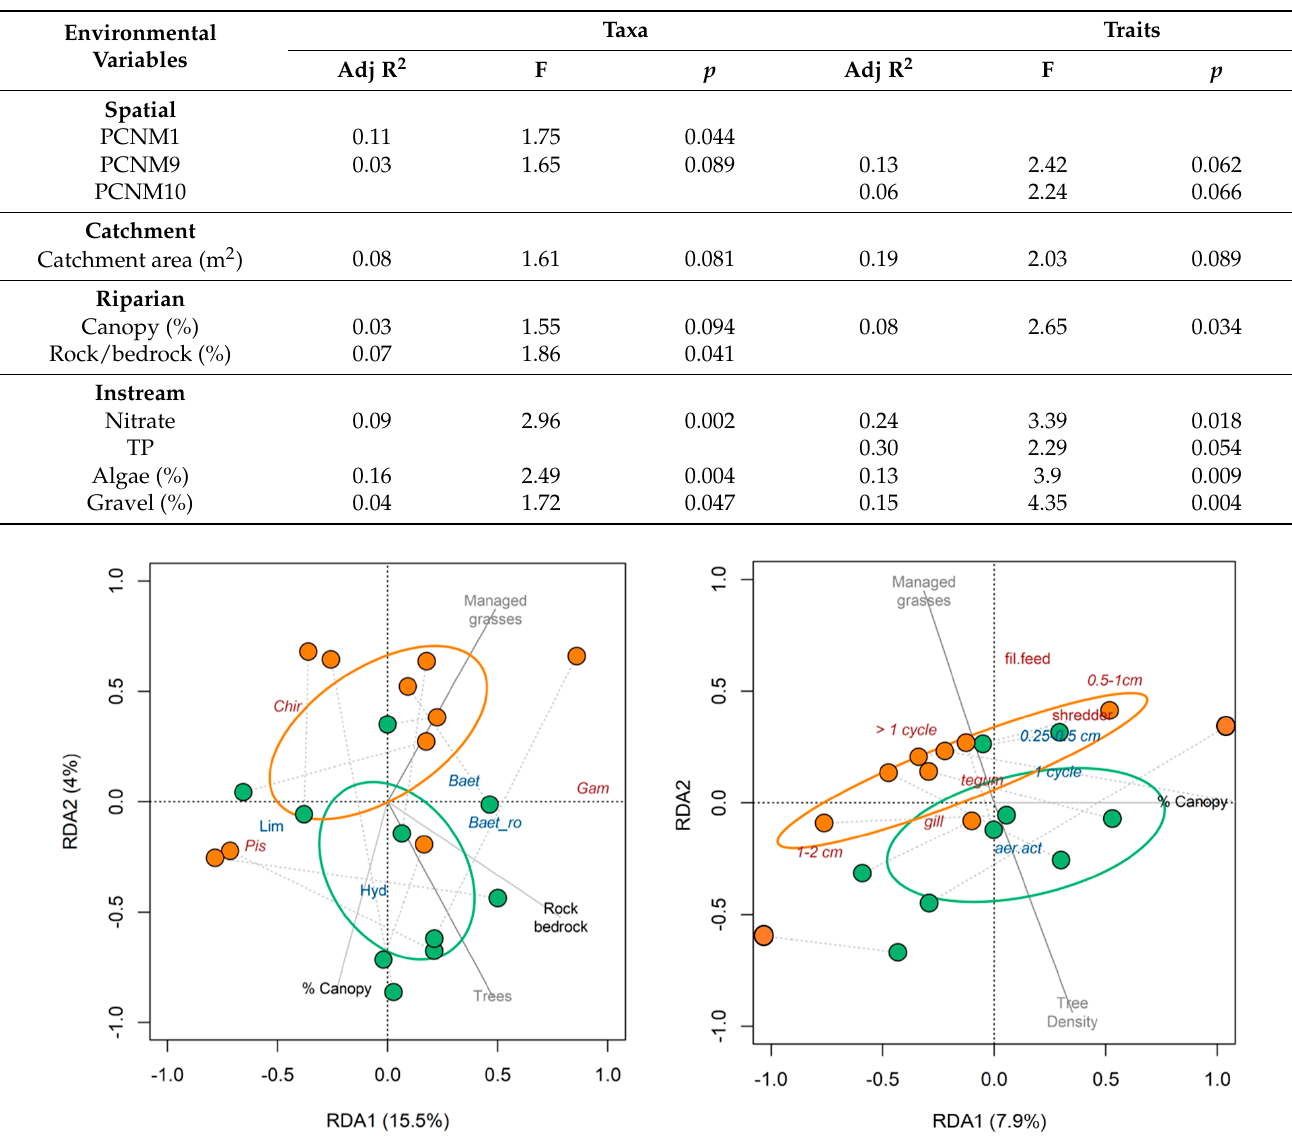
Table 2. Results of RDA analysis (forward selection) showing environmental variables from each tested model with significant conditional effects on taxonomic ( n = 94) and trait ( n = 39) composition.